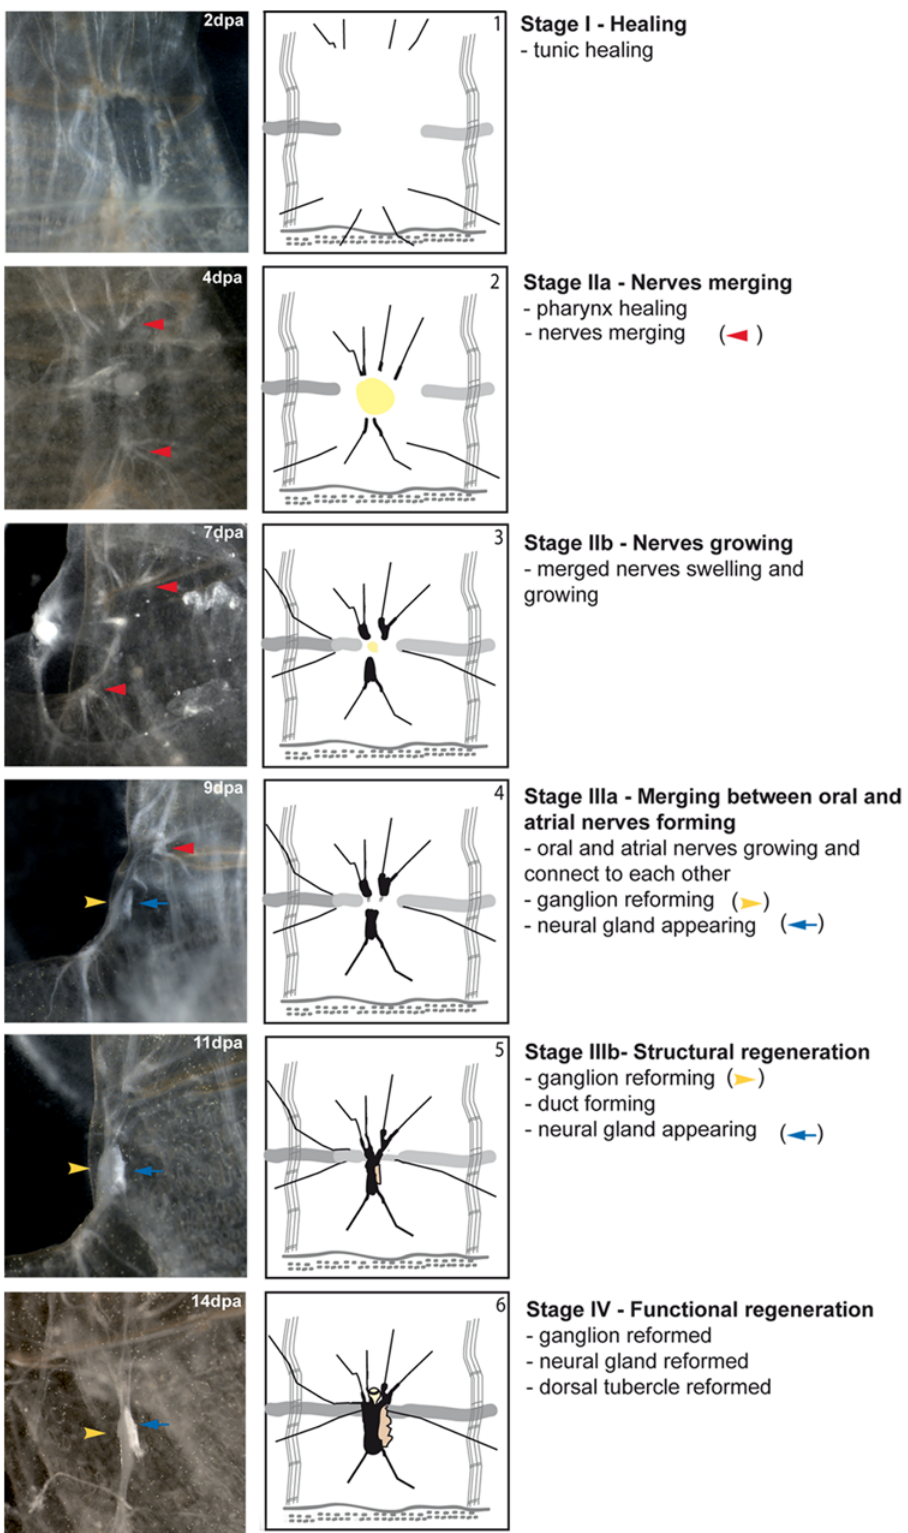
Figure 2. Visualizing the stages of regeneration. The first column shows the various stages of the regeneration process in a single middle-sized animal. The second column shows the regeneration process in a small animal. The third column provides a short description of the main features of the different stages of the process. Stereomicroscope images taken with the Leica MZFLIII ( , 8 6 ).